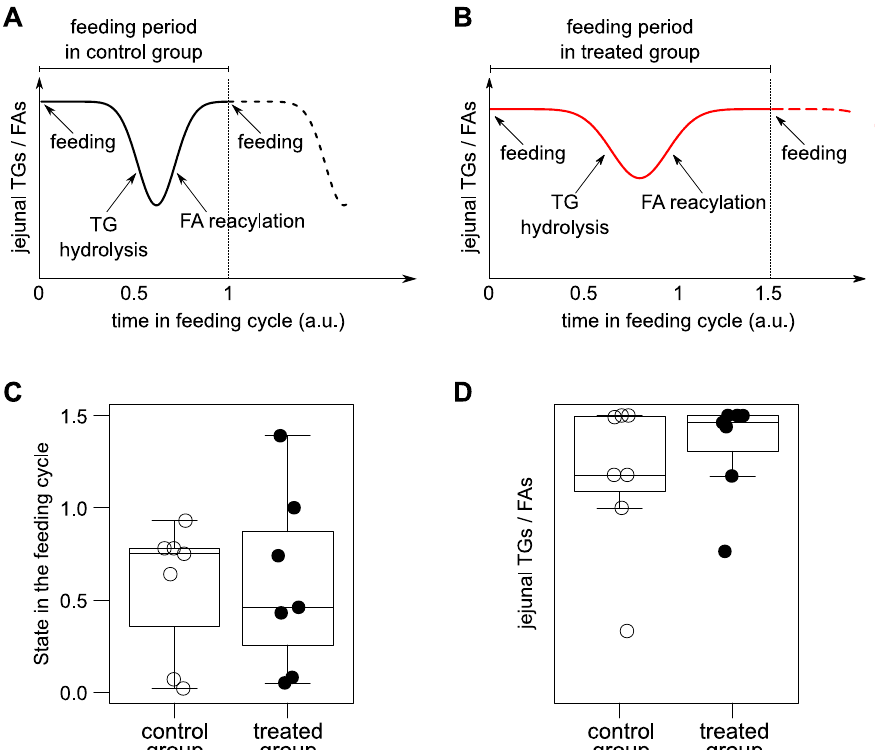
Figure 1. Simulation of the effect of ad libitum feeding on the ratio TGs/FAs in the jejunum. ( A ) Illustration of the change of the ratio TGs/FAs in the jejunum during the feeding period. ( B ) Illustration of the change of the feeding period in a treatment that increases the feeding period by 50% and affects the length of stay of the bolus in the jejunum. ( C ) Simulation of ad libitum feeding on the point of the animals in the feeding cycle. The position of the animals in the feeding cycle at sacrifice was simulated by sampling a uniform distribution between 0 and 1 for the control group (n = 7) and sampling a uniform distribution between 0 and 1.5 for the treated group (n = 7). ( D ) Values of the ratio TGs/FAs of the simulations in panel C, according to the curves shown in panels A and B. Ad libitum feeding provokes that the ratio TGs/FAs is not matched between the two groups. In addition, even if it would be paired by chance, the same ratio TGs/FAs could correspond to two different points in the digestion: when TG hydrolysis dominates or when FA acylation dominates. Consequently, even if the average ratio TGs/FAs is matched, the animals could be in two different digestion states and bias the analysis.